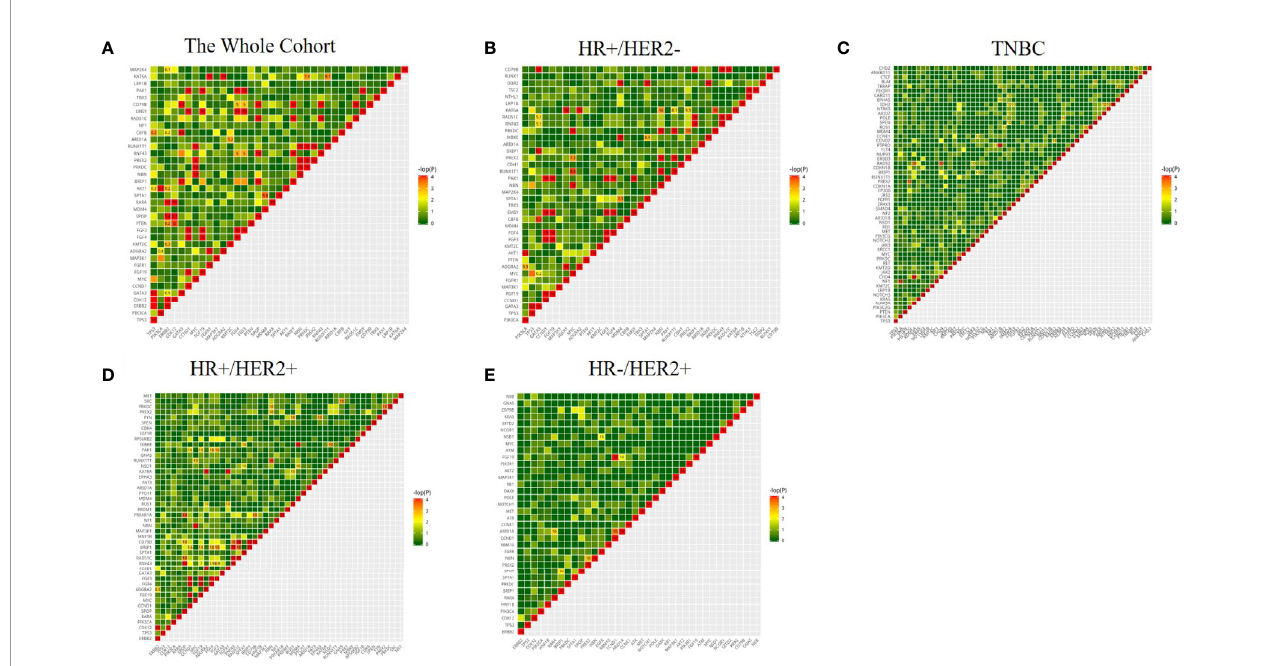
FIGURE 5 | Coexisting and mutually exclusive gene mutations in 520 cancer-related gene aberrations in the whole cohort (A) and various molecular subtypes of breast cancer (B – E) . Genes with a mutation rate of ≥ 4% were included in the analysis; the color represents the trend of correlation, the numbers represent the mutually exclusive association of genes, Odds ratio (OR) >5 tends to be associated, OR<0.5 tends to be mutually